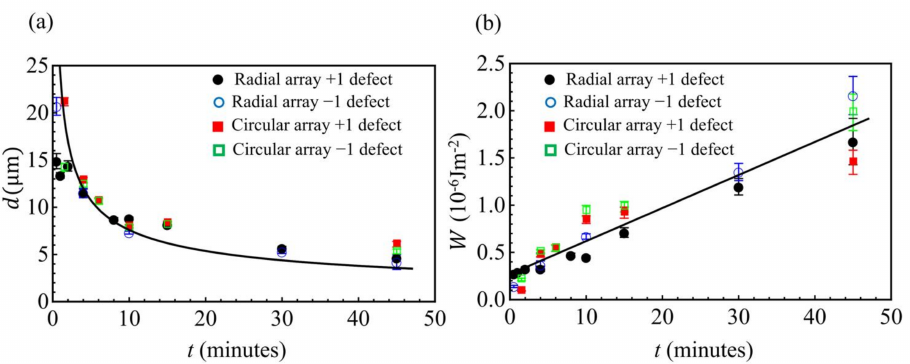
Figure 5. Defect Separation and Surface Anchoring. ( a ) The separation distance d between half-integer defects cores and ( b ) the azimuthal surface anchoring coefficient W as functions of the photopattern- ing